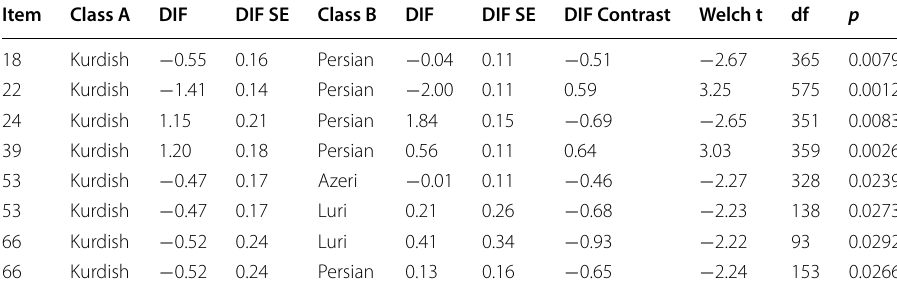
Table 8 Results of uniform DIF analysis of items (IUUESEE 2017)